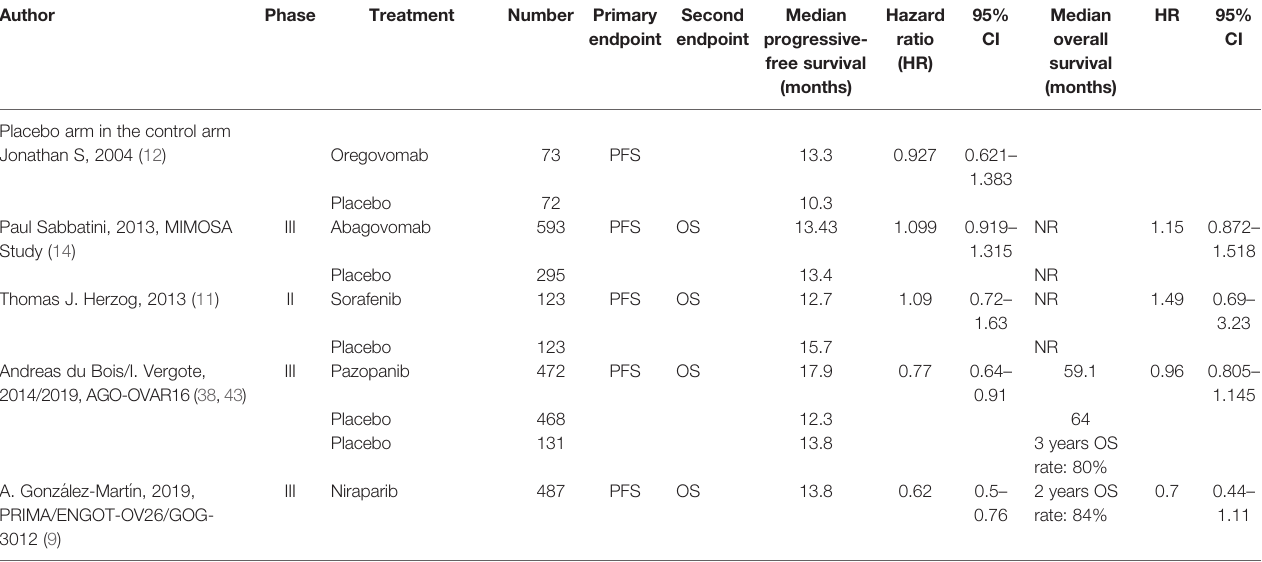
TABLE 1 | Baseline characteristics of the included studies.